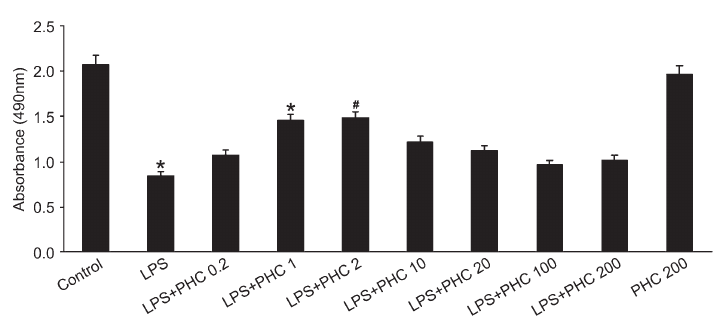
Figure 3. Comparison of methyl thiazolyl tetra- zolium (MTT) assay results (n=5). PHC: penehy- clidine hydrochloride (0.2-200 m g/mL) *P , 0.05, compared with control group; # P , 0.05, com- pared with lipopolysaccharide (LPS) group (ANOVA).